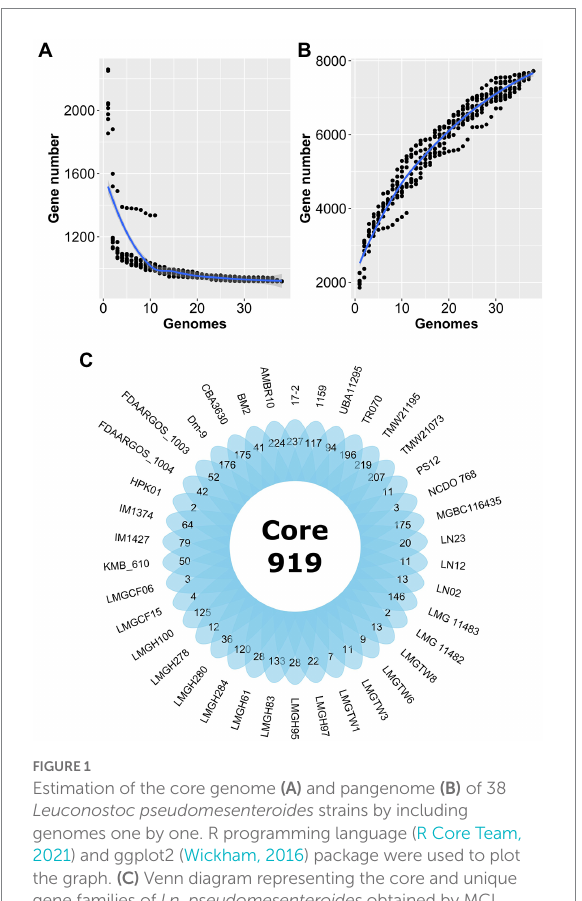
FIGURE 1 Estimation of the core genome (A) and pangenome (B) of 38 Leuconostoc pseudomesenteroides strains by including genomes one by one. R programming language (R Core Team, 2021) and ggplot2 (Wickham, 2016) package were used to plot the graph. (C) Venn diagram representing the core and unique gene families of Ln. pseudomesenteroides obtained by MCL clustering algorithm